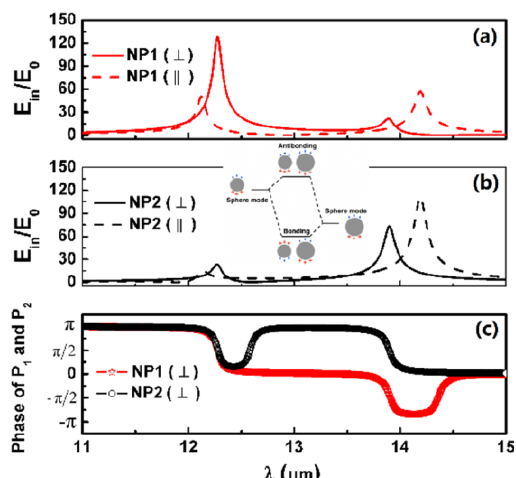
Figure 10. Internal field enhancement spectra in ( a ) NP1 and ( b ) NP2 with di ff erent polarization direction of incident wave: E perpendicular to dimer axis (solid) and E parallel to dimer axis (dashed). ( c ) Phase of the dipole moments for NP1 and NP2 in case of E perpendicular to dimer axis. Other physical parameters are the same as in Figure 2IV. The insert denotes the plasmon